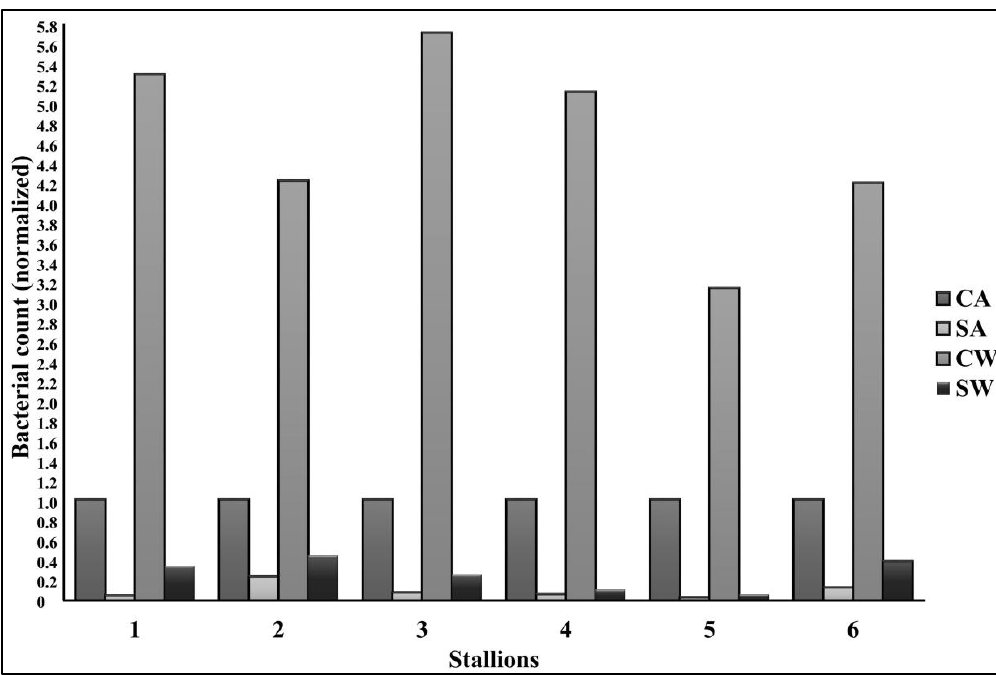
Figure 5. Total bacterial colony counts per treatment group relative to control with antibiotics (at 0 h); control with antibiotics has been normalized to 1 arbitrary unit. Abbreviations: CA, control with antibiotics; SA, modified single layer centrifugation with antibiotics; CW, control without antibiotics; SW, modified single layer centrifugation without antibiotics.